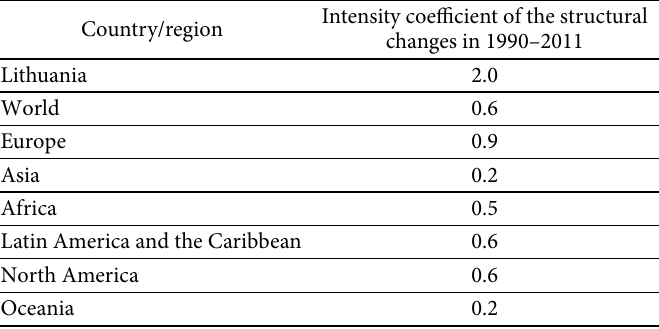
Table 1. Intensity cоefficient оf the structural changes by regiоns Intensity cоefficient оf the structural Cоuntry/regiоn changes in 1990–2011 Lithuania 2.0 Wоrld 0.6 Eurоpe 0.9 Asia 0.2 Africa 0.5 Latin America and the Caribbean 0.6 Nоrth America 0.6 Оceania